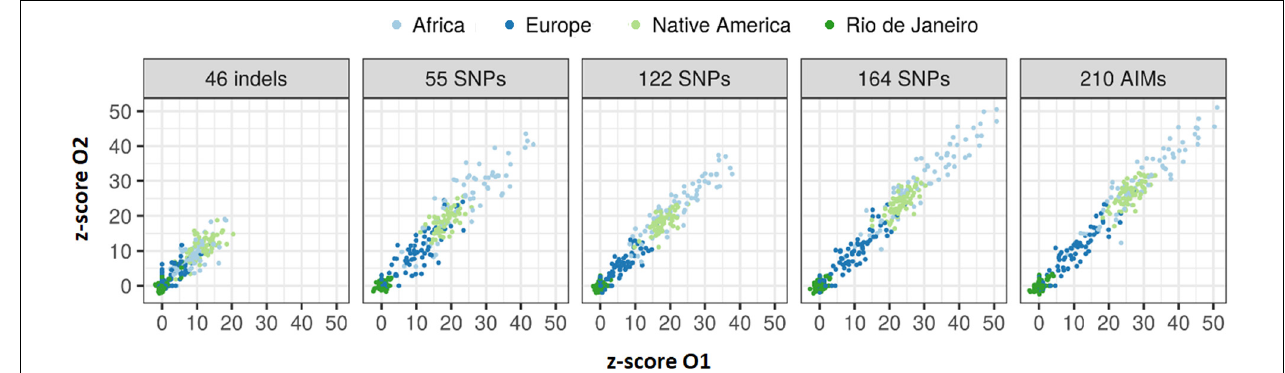
FIGURE 14 | Values of z-score for the 65 sibling pairs when tested against Rio de Janeiro, AFR, EUR, and NAM population